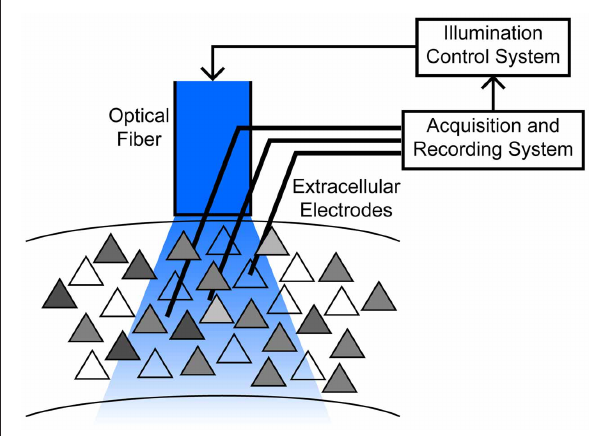
FIGURE 1 | Schematic of the motivating application, typical of chronic implants in freely moving animals. An optical fiber is chronically implanted above a cortical area containing hundreds to thousands of neurons with varying degree of ChR2 expression ( gray shading ). Responses to stimulation are heterogeneous due to these expression differences, as well as their location relative to the fiber, cell properties such as electrotonic size and other channel densities, etc. Multiple electrodes penetrate into a broad region illuminated by the fiber, permitting observation of a small subset of neurons. See (Siegle et al., 2011) for example